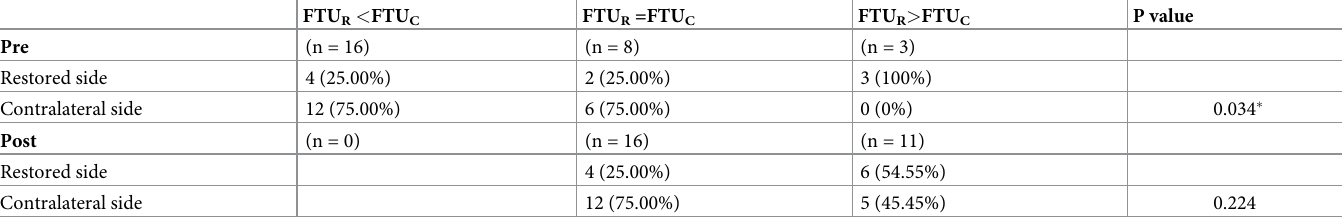
Table 6. Comparison of the occlusal force center location of different functional teeth units (before treatment vs immediately following